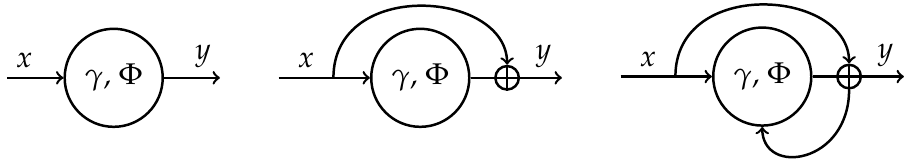
Figure 1. From left to right: feed forward layer, residual layer, proposed implicit residual